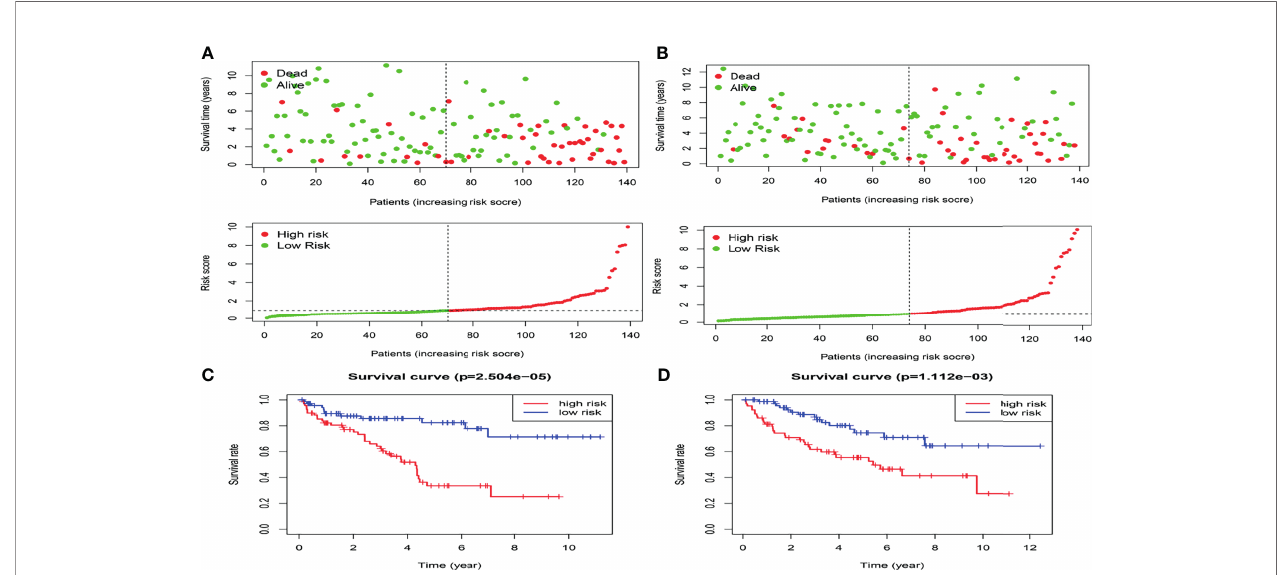
FIGURE 3 | The distribution of the risk scores as well as the relationship between the risk scores and survival status in the training cohort (A) and validation cohort (B) .The result of K-M analysis for the hypoxia-related risk model in the training cohort (C) and validation cohort (D)